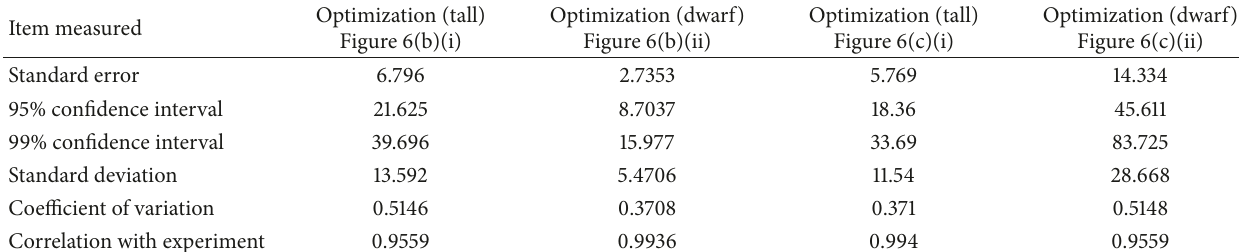
Table 12: Statistical analysis of